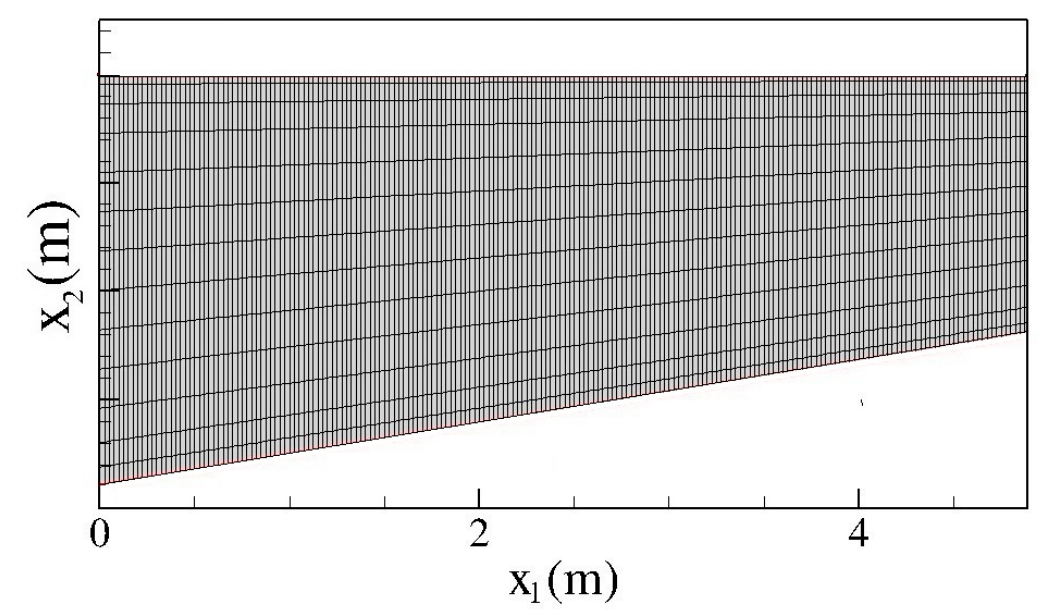
Figure 3. Zoomed in view of the numerical mesh used for the simulations.